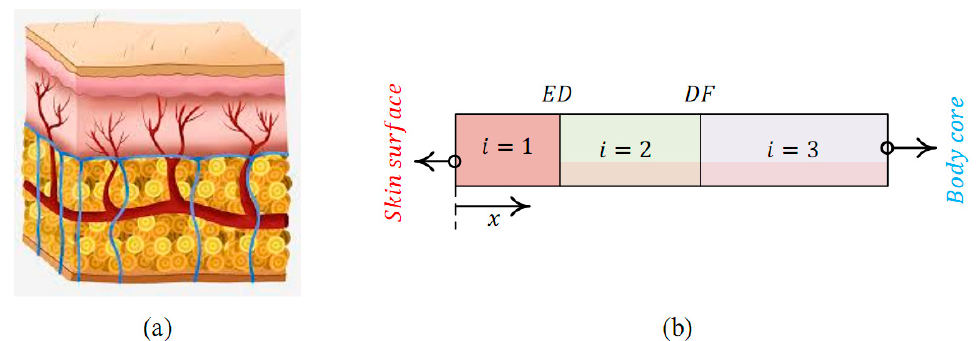
Figure 2. ( a ) Schematic view of the skin tissue, and ( b ) tissue layers; i = 1 for epidermis, i = 2 for dermis, and i = 3 for subcutaneous fat.